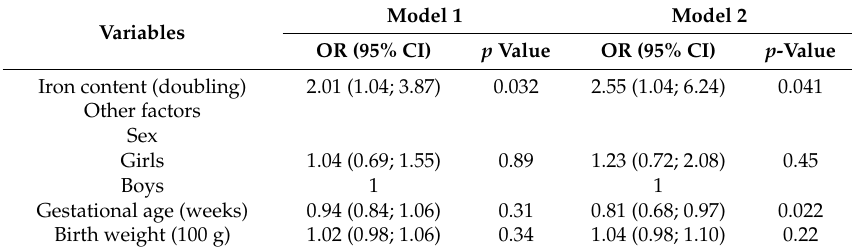
Table 2. The odds ratios for T1D development in newborns per doubling of iron content in